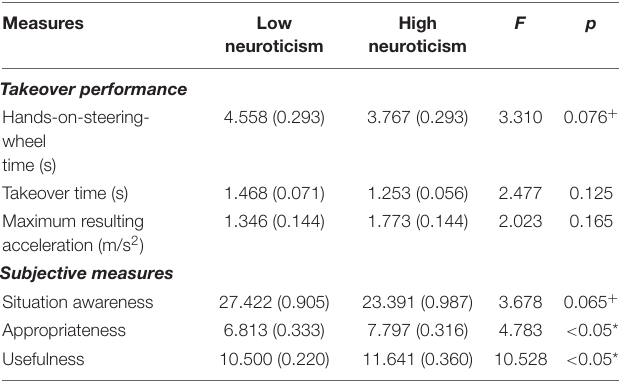
TABLE 3 | Mean and standard errors of the takeover performance and subjective ratings for low-neuroticism and high-neuroticism drivers. Measures